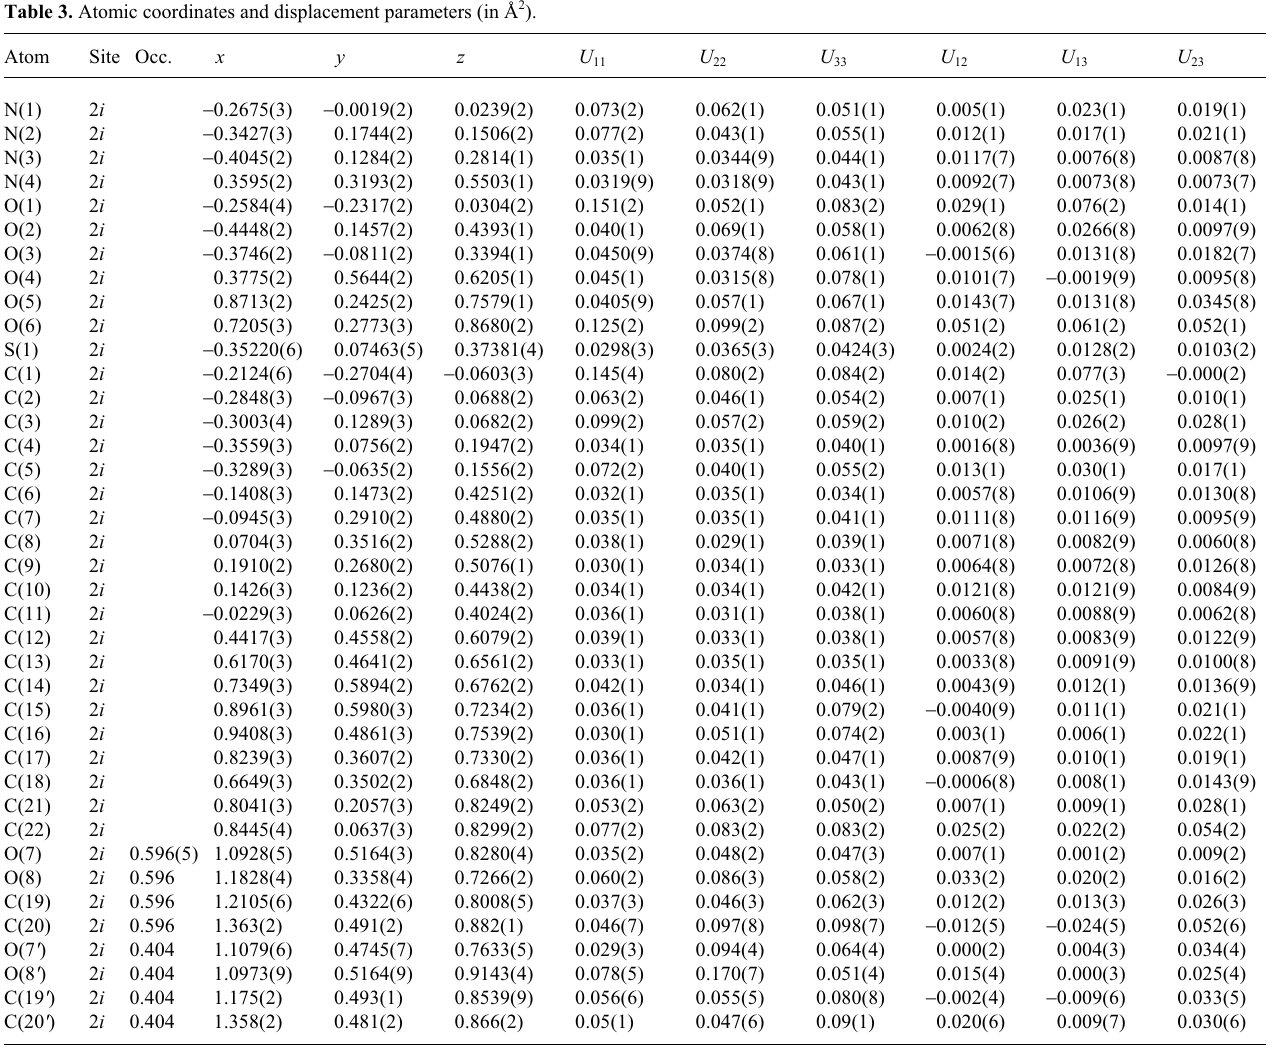
Table 3. Atomic coordinates and displacement parameters (in Å 2